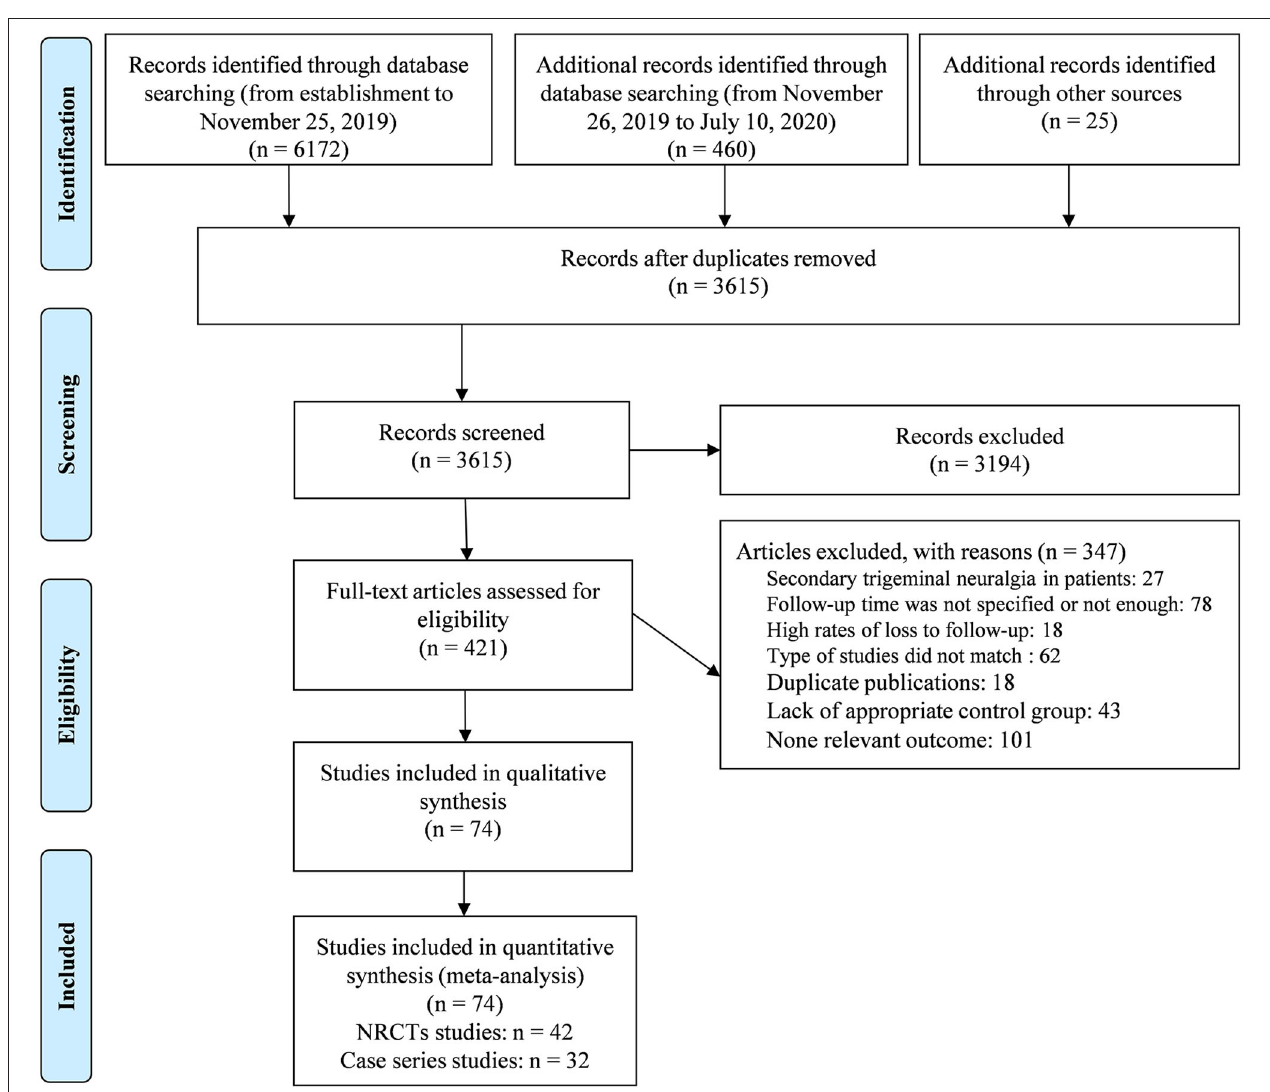
FIGURE 1 | PRISMA flowchart indicating studies identified by and included in the systematic review.